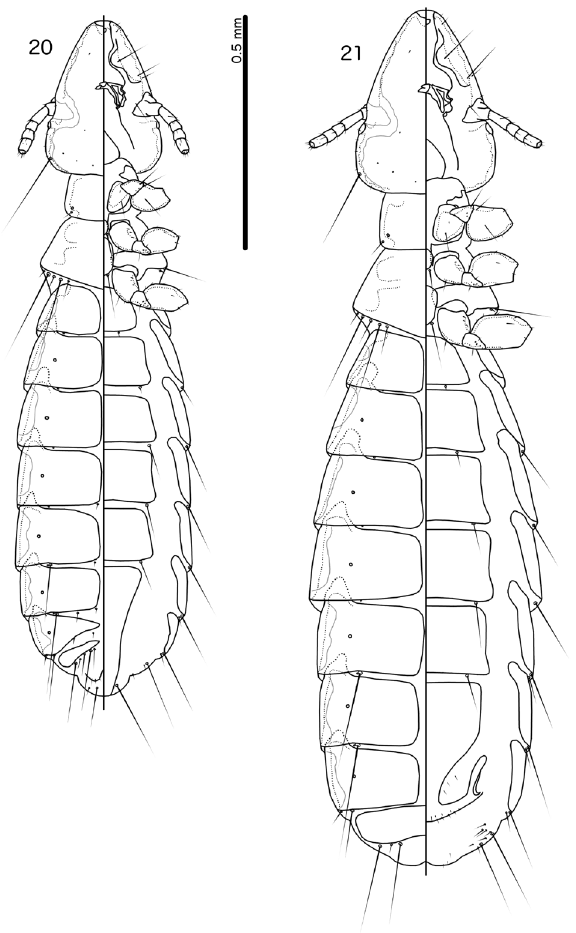
Figures 20, 21. Brueelia glizi Balát, 1955, ex Fringilla mon- tifringilla Linnaeus, 1758 20 Male habitus, dorsal and ventral views 21 Female habitus, dorsal and ventral